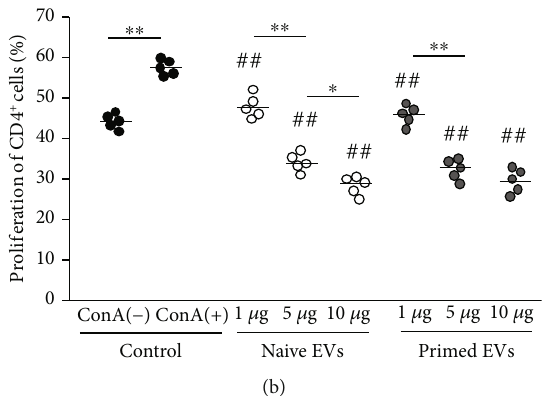
Figure 4: Proliferative ability of CD4 + T cells cocultured with cADSC-EVs. (a) Proliferation of CD4 + T cells was assayed using the CFSE method by fl ow cytometry. Segments represent the percentages of CD4 + T cell proliferation. (b) Comparison of proliferative CD4 + T cells treated with various concentrations (1, 5, and 10 μ g/ml) of naive or primed cADSC-EVs. The inhibitive e ff ects on CD4 + T cells were not signi fi cantly di ff erent between naive and primed EVs at same concentrations. The solid line indicates the average. ## P < 0 : 01 vs. CD4 + T cells stimulated with ConA. ∗ P < 0 : 05 , between groups. ∗∗ P < 0 : 01 , between